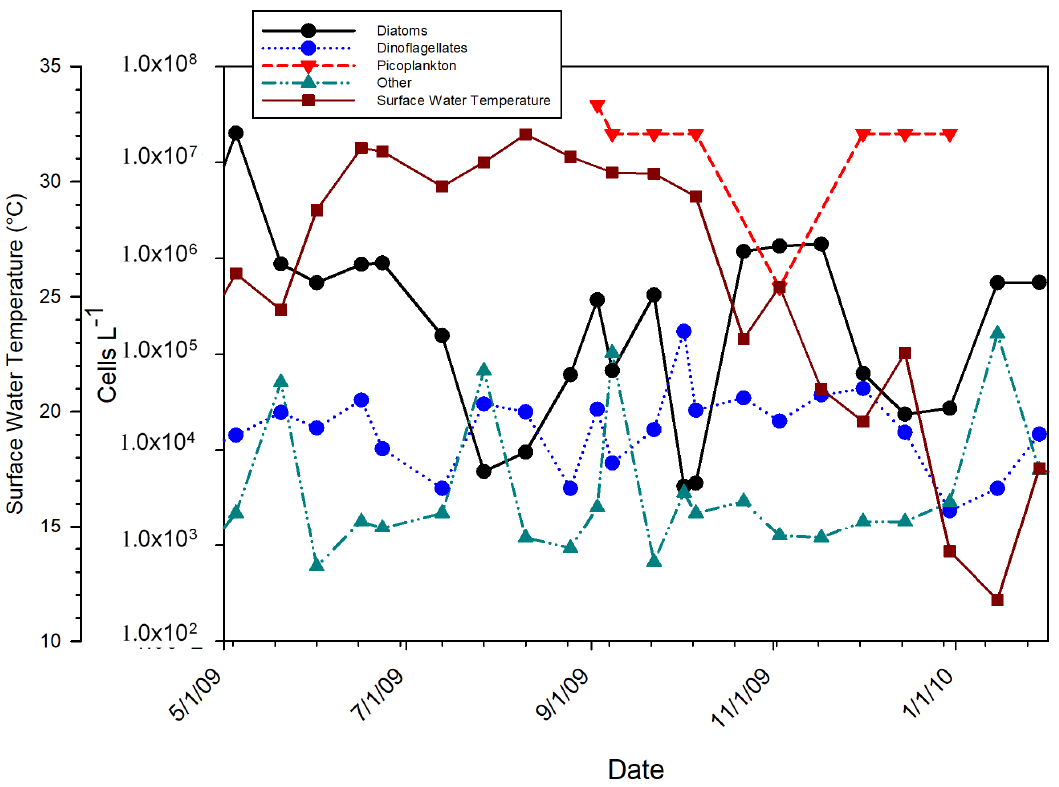
Figure 4. Phytoplankton functional groups identified and enumerated using a modified Utermöhl microscopy technique. Picoplankton concentrations are based on enumeration of cells in optical fields using epifluorescent microscopy.